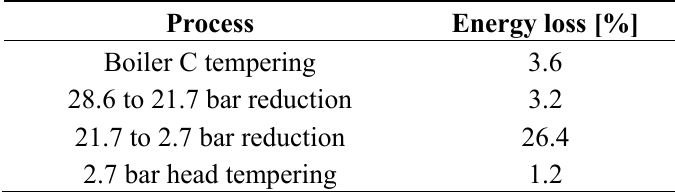
Table 2. Energy losses in pressure reductions and tempering water addition at